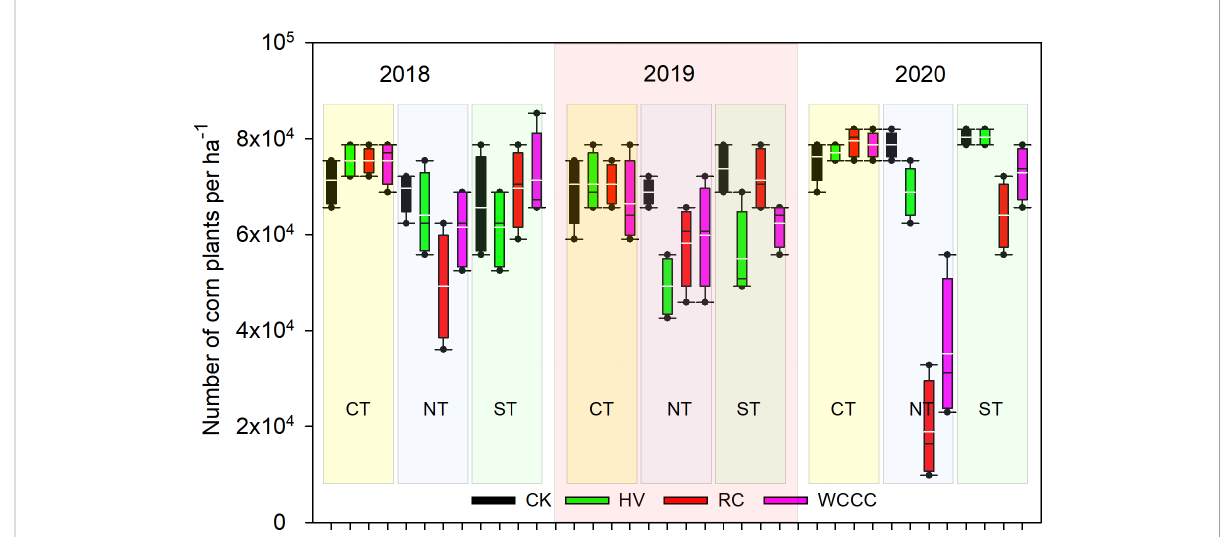
FIGURE 2 Corn stands (plant ha − 1 , two weeks after planting) by year from 2018 to 2020 grouped by cover crop species and cover crop termination-tillage method. CT, fall moldboard plow-down termination followed by spring planting; NT, spring herbicide spray-down termination followed by no- till corn planting; ST, spring herbicide spray-down termination followed by strip tilling and corn planting; CK, no cover crop control; HV, hairy vetch; RC, red clover; WCCC, white and crimson clover mix. Boxes indicate the 25th and 75th percentile; solid dots above and below the box indicate the 90th and 10th percentile, respectively; white horizontal lines indicate mean; black horizontal lines indicate median.